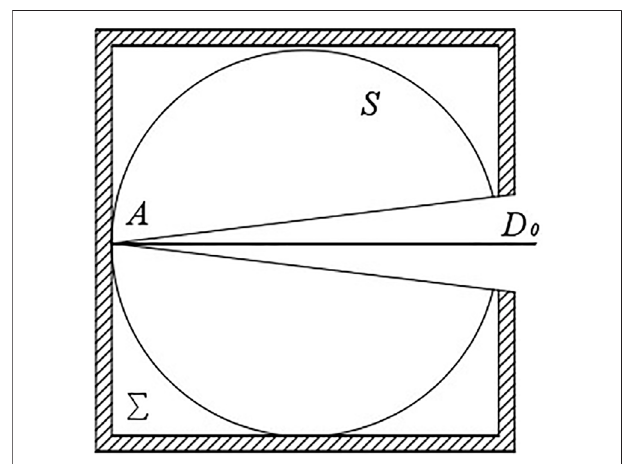
FIGURE 1 | Circular blackbody cavity